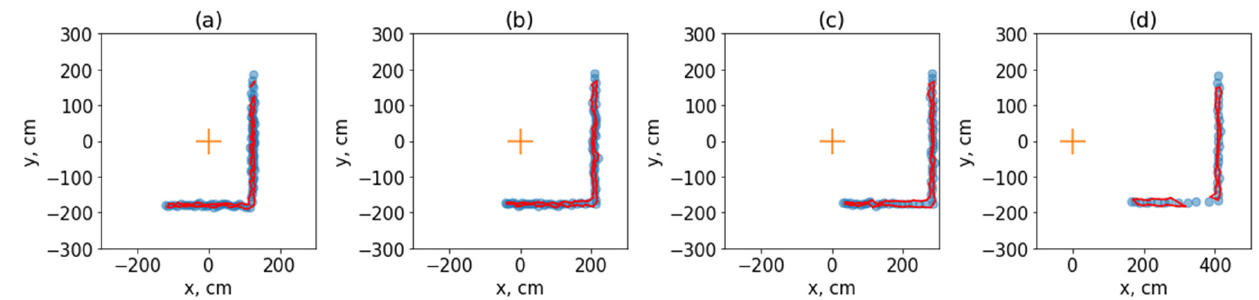
Figure 2. In each figure, the position of the LiDAR sensor, which coincides with the initial coordinate system, is shown in orange. The red colour indicates the predicted obstacles. The blue colour indicates the sensor image. ( a ) The block is at a distance of 100 cm from the sensor. ( b ) The obstacle is at a distance of 200 cm from the sensor. ( c ) The obstacle is at a distance of 300 cm from the sensor. ( d ) The obstacle is at a distance of 400 cm from the sensor.